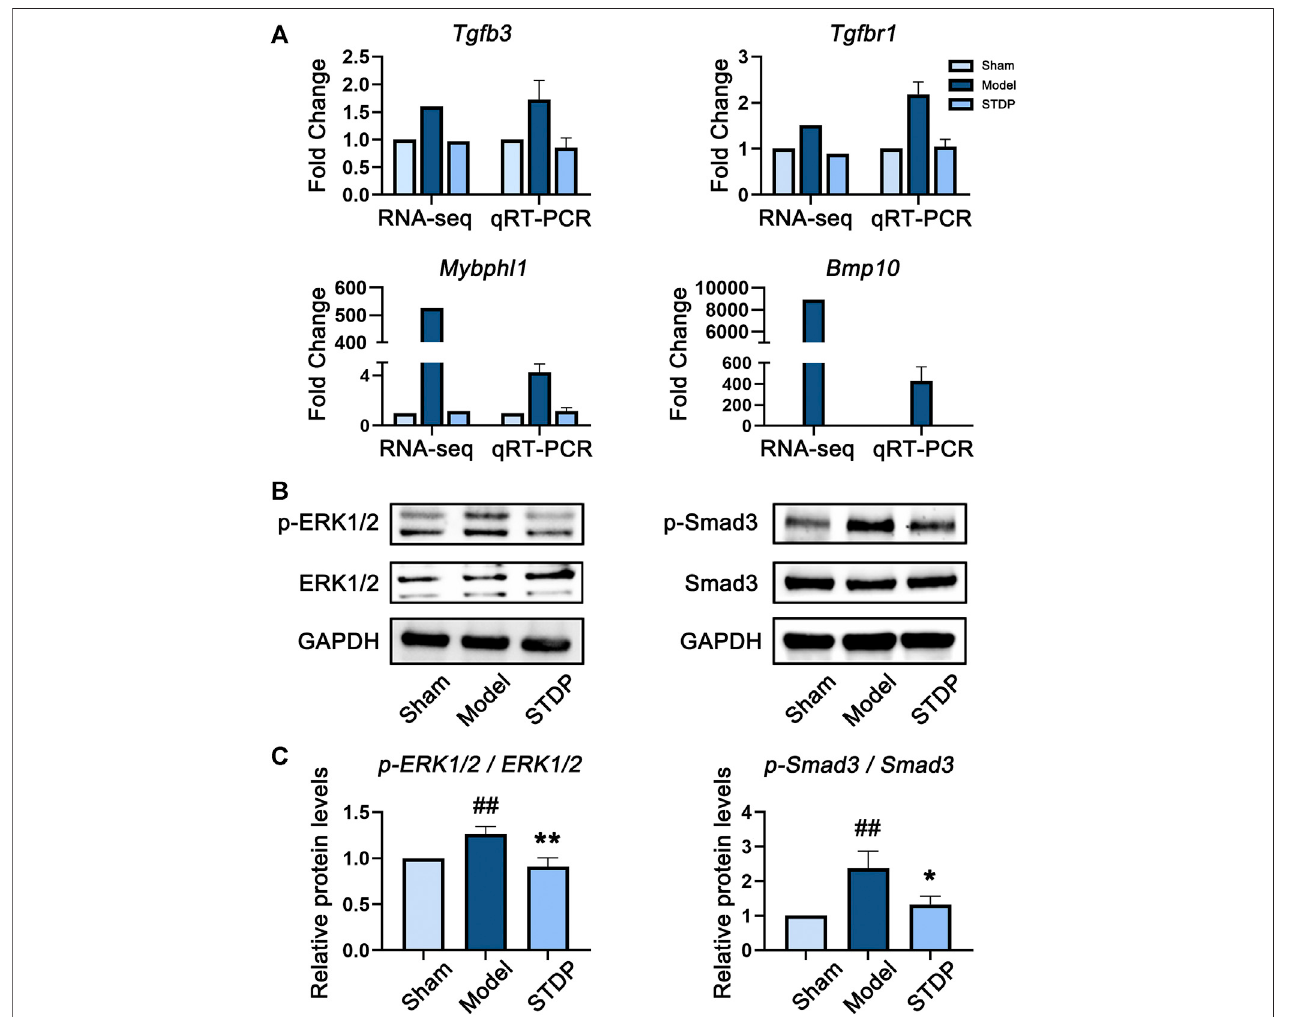
FIGURE6| STDPprotectsmiceagainstCHF via downregulatingERK/MAPKandTGF- β pathways. (A) Thegeneexpressionlevelsof Tgfb3 , Tgfbr1 , Mybphl1 ,and Bmp10 detectedbytranscriptomesequencingandqRT-PCR.Theinternalreferencewas Actb ,n (cid:1) 3. (B) Theproteinexpressionlevelsof p -ERK1/2,ERK1/2, p -Smad3, and Smad3 inheart tissues detectedbyimmunoblotanalysis.GAPDH wasused asthe internal standard. (C) The quantitative results calculated byImageLab software. ## p < 0.01 versus the Sham group; * p < 0.05 and ** p < 0.01 versus the Model group; n (cid:1) 3.